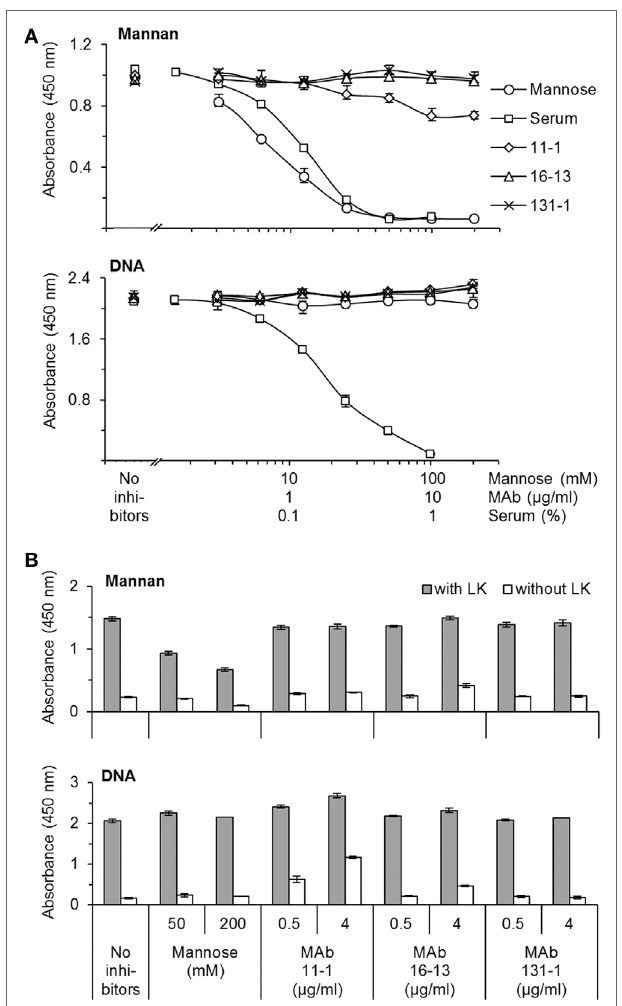
FigUre 2 | Characterization of mAbs’ impact on the ligand-binding and complement activity mediated by CL-LK. (a) Impact on ligand-binding. CL-LK was incubated on ligand-coated plates (mannan or DNA) in the presence or absence of the mAbs used for IHC (mAb 11-1 and mAb 16-13), mannose, or serum (known to interfere with the binding of CL-LK to ligands). mAb 131-1 (anti-MBL) was included as control. Bound CL-LK was detected with biotinylated mAb-anti-CL-K1 (compatible with the applied mAbs) and HRP-streptavidin. (B) Impact on CL-LK-mediated complement activation. Prior to incubation with MASP-2 and C4, plates were prepared with CL-LK and coated ligands (mannan or DNA) as above. Deposition of C4b was detected with biotin-labeled anti-C4b mAb and HRP-streptavidin. The results shown are representative of three independent experiments. Error bars refer to max and min of triplicate measurements. None of the tested mAbs interfered with ligand binding or complement activation. CL-LK binding to mannan and DNA occurs via two separate binding site, and the latter is not inhibited by mannose, whereas uncharacterized blood components inhibit both types of interaction (10,